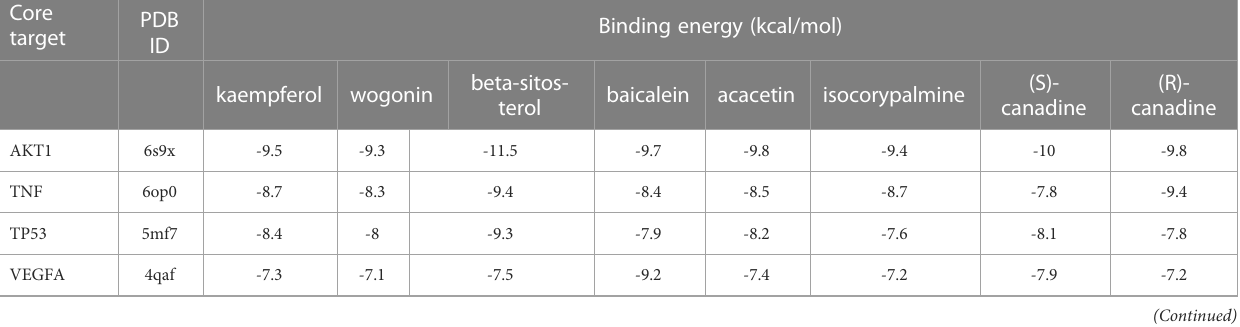
TABLE 4 Docking results of target proteins and active